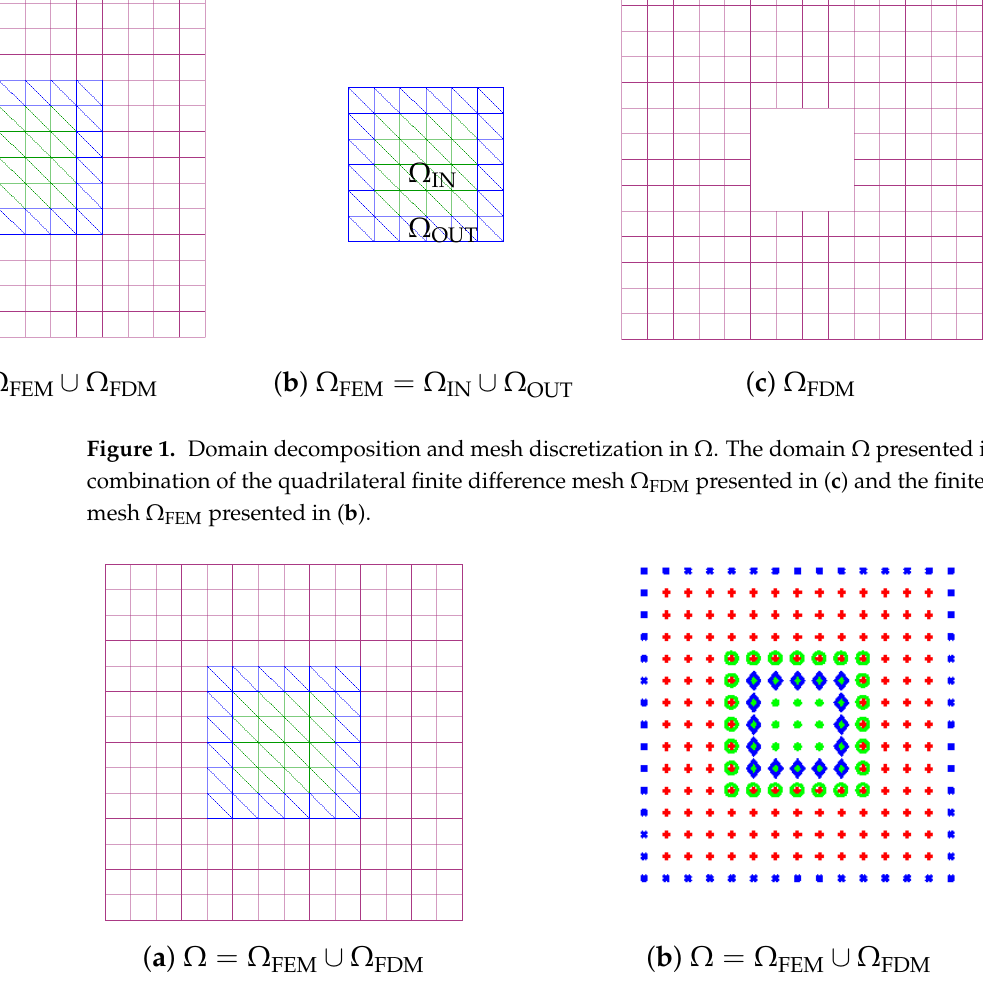
Figure 2. Coupling between Ω FEM and Ω FDM . The nodes of the FE/FD mesh of ( a ) are presented also on ( b ) as sets of following nodes: ω o (green circles), ω (red pluses), ω x (blue crosses). These sets are described in the domain decomposition algorithm.